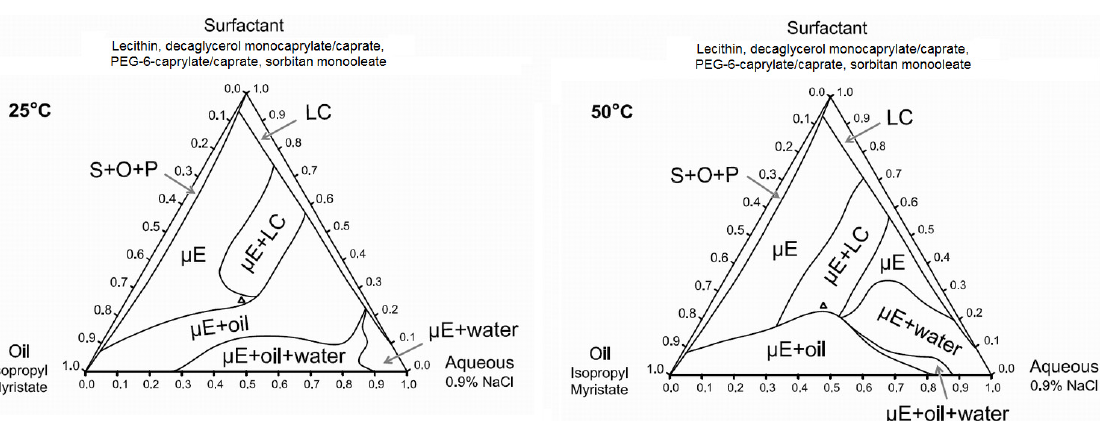
Figure 2. Ternary phase diagrams of 6% SMO formulation at 25 °C and 50 °C. The surfactant vertex is a mixture of 1:2:0.8:1.2 weight ratio of lecithin: PEG-6-caprylic/capric glycerides:decaglycerol monocaprylate/caprate:SMO. The point “ ∆ ” indicates the composition of the base formulation containing 6%